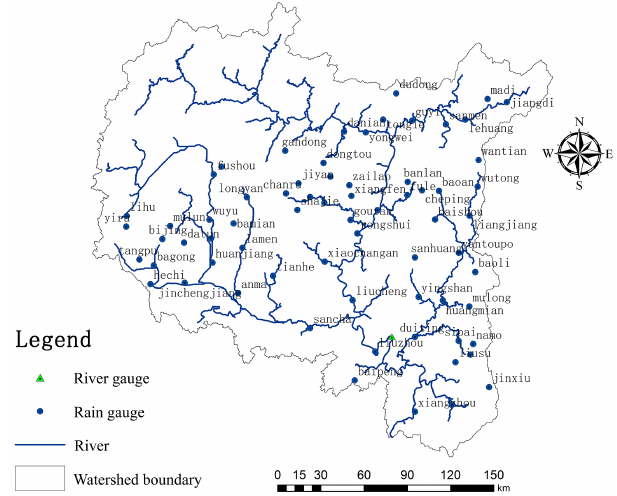
Figure 1. Sketch map of the Liujiang River basin